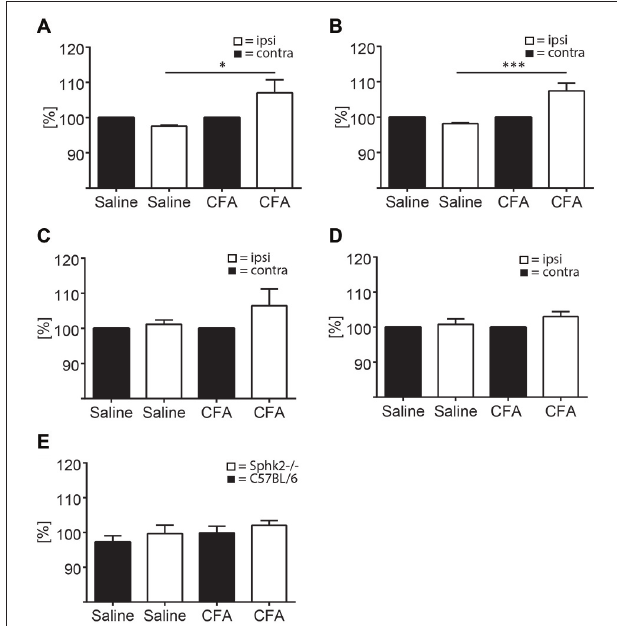
FIGURE 9 | Microglia and astrocytes in the dorsal horn in C57BL/6 and Sphk2 − / − mice in response to chronic inflammation. Areas of the ipsi- and contralateral (contra) SC dorsal horn with IR for GFAP (A,C) , Iba-1 (B,D) and positive staining for Dapi (E) in C57BL/6 (A,B,E) and Sphk2 − / − (C, D) lumbosacral SC 7 days post injection of CFA (CFA) or saline (saline) into the left hindpaw. Values represent mean ± SEM, n = 5, one-way